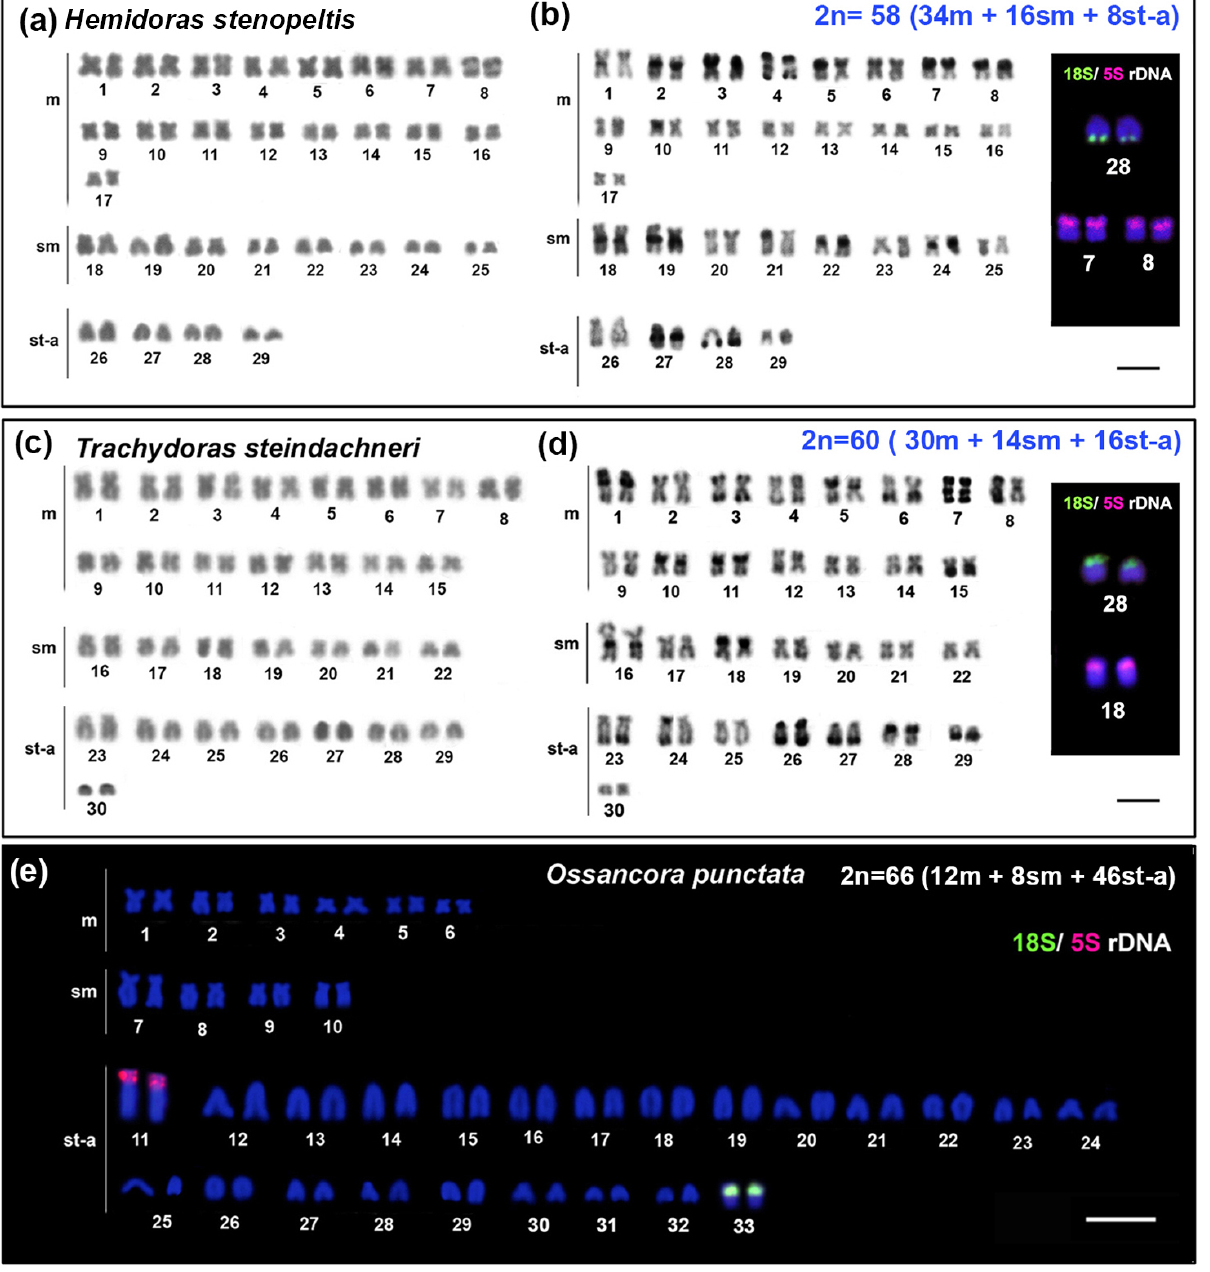
Figure 2 – Karyotypes of the Doradinae subfamily “fimbriate barbells thorny catfishes”: Hemidoras stenopeltis (a) Giemsa, (b) C-band; Trachydoras steindachneri (c) Giemsa, (d); The boxes contain the chromosome pairs bearing the 18S and 5S rDNA rDNA sites. (e) karyotype of Ossancora punctata after FISH with 18S and 5S rDNA probes. The scale bar corresponds at 10